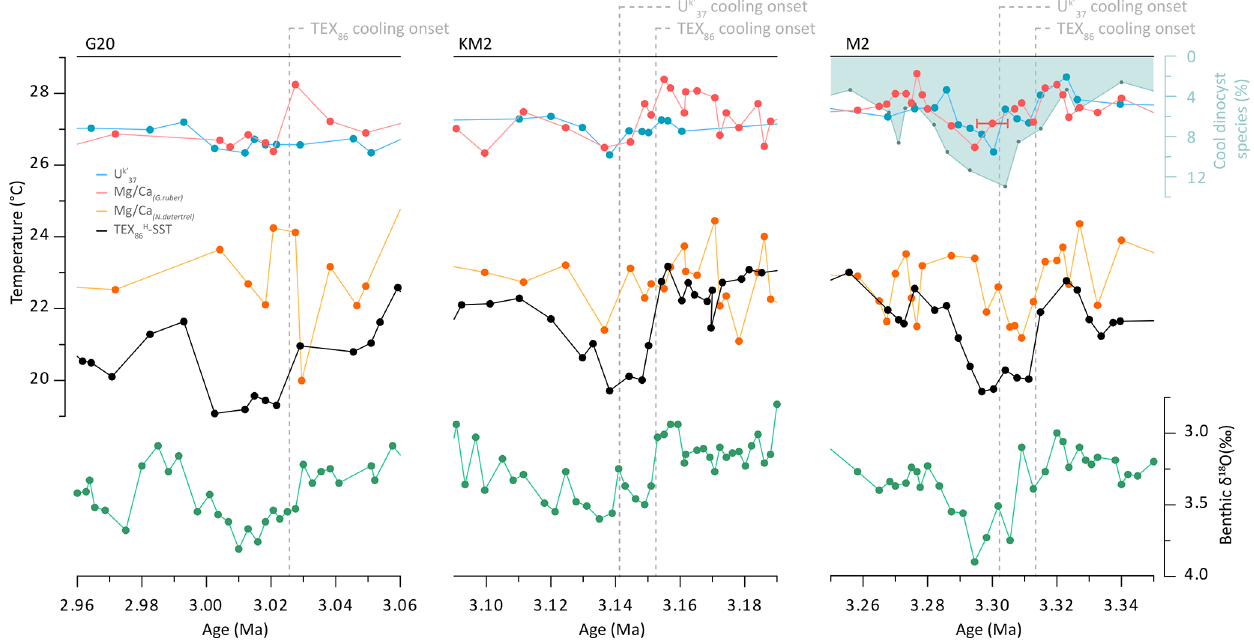
Figure 6. Close-up of G20, KM2 and M2 glacial stages in 100kyr windows. Multi-proxy temperature data and benthic δ 18 O as in Fig. 5. The resolution of the dinocyst record was too low for meaningful comparisons in KM2 and M2 glacials.